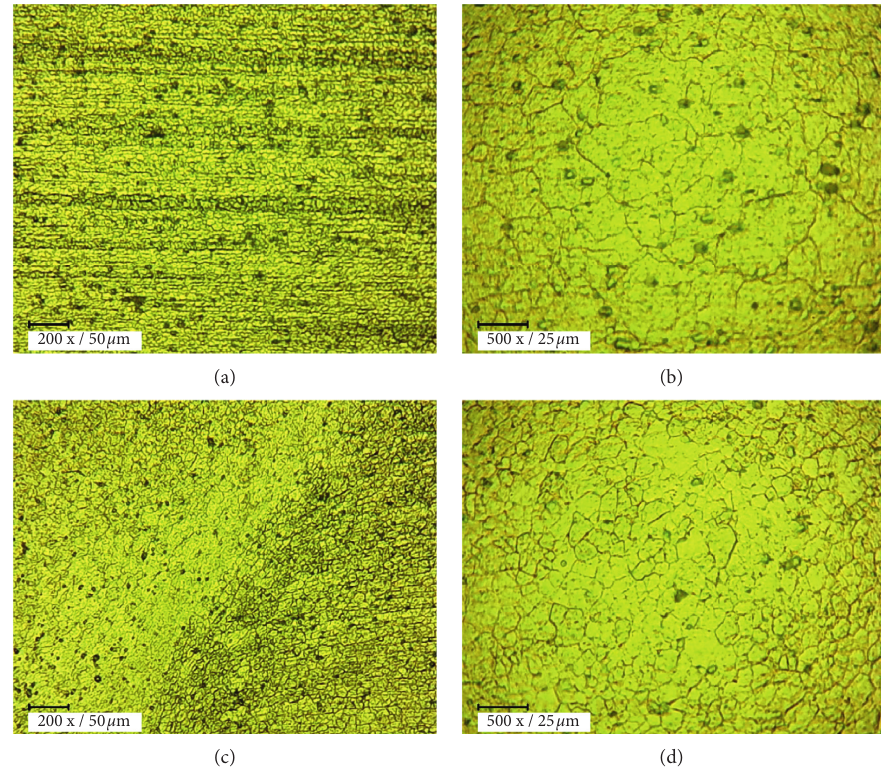
Figure 19: Detailed microscopic image for cryogenic friction stir welding of AA 7075 aluminium alloy. (a) Parent. (b) HAZ. (c) Interface. (d) Weld nugget zone.